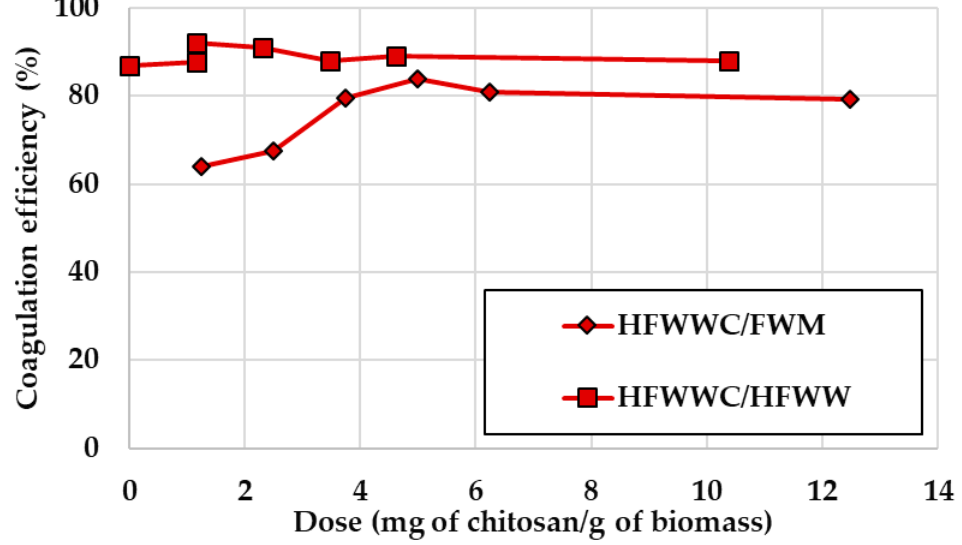
Figure 5. Coagulation efficiency (%) as a function of the chitosan dose (in mg of chitosan per g of biomass) for HFWWC grown in FWM and HFWW.